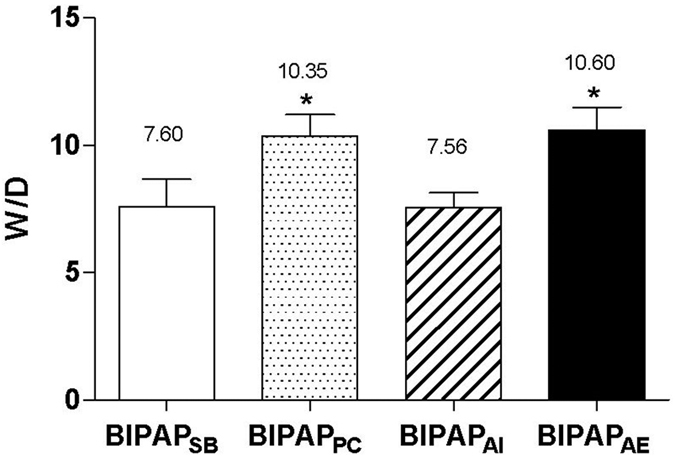
The Levels of Wet to dry weight ratio (W/D) after 8 h mechanical ventilation.BIPAPSB = biphasic positive airway pressure with SB; BIPAPPC = biphasic positive airway pressure with muscles paralysis; BIPAPAI = biphasic positive airway pressure with inspiratory muscles activity; BIPAPAE = biphasic positive airway pressure with expiratory muscles activity. SB = spontaneous breathing; NS = no significantly difference, *P < 0.05 vs. BIPAPSB and BIPAPAI groups.